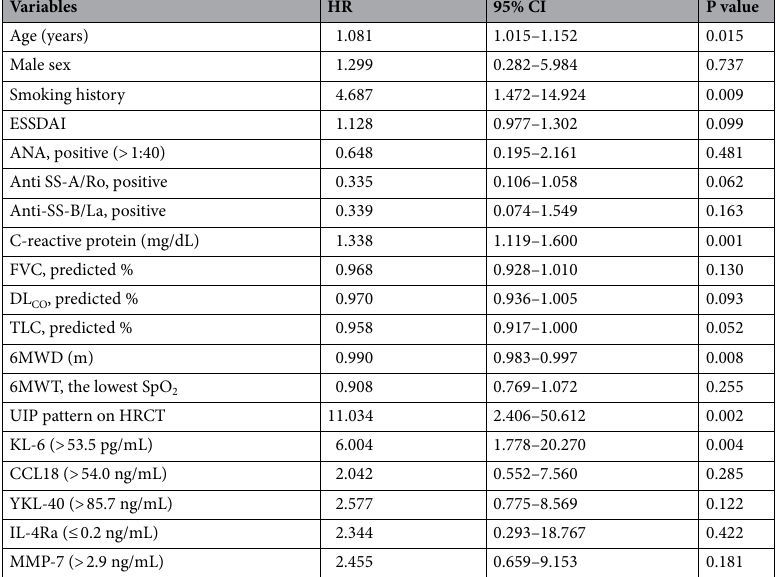
Table 3. Risk factors for mortality in patients with SJS-ILD assessed using a unadjusted Cox proportional hazards model. 6MWD six-minute walk test distance, 6MWT the lowest SpO2 lowest oxygen saturation